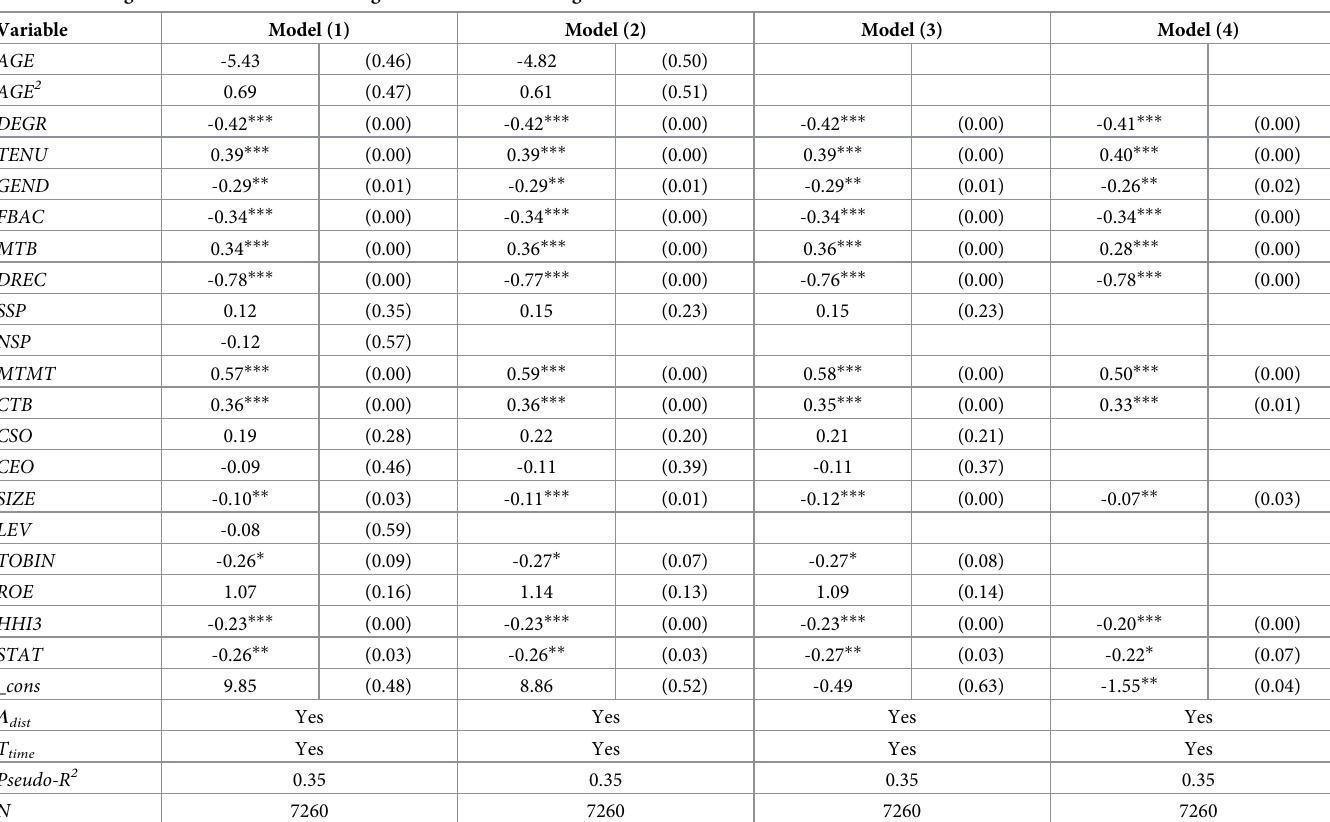
Table 3. The regression results of the first stage of Heckman’s two-stage